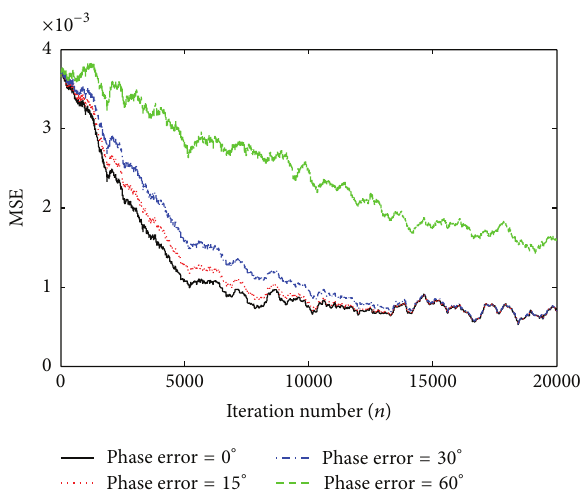
Figure 17: The MSE using the hybrid control under different 𝑄